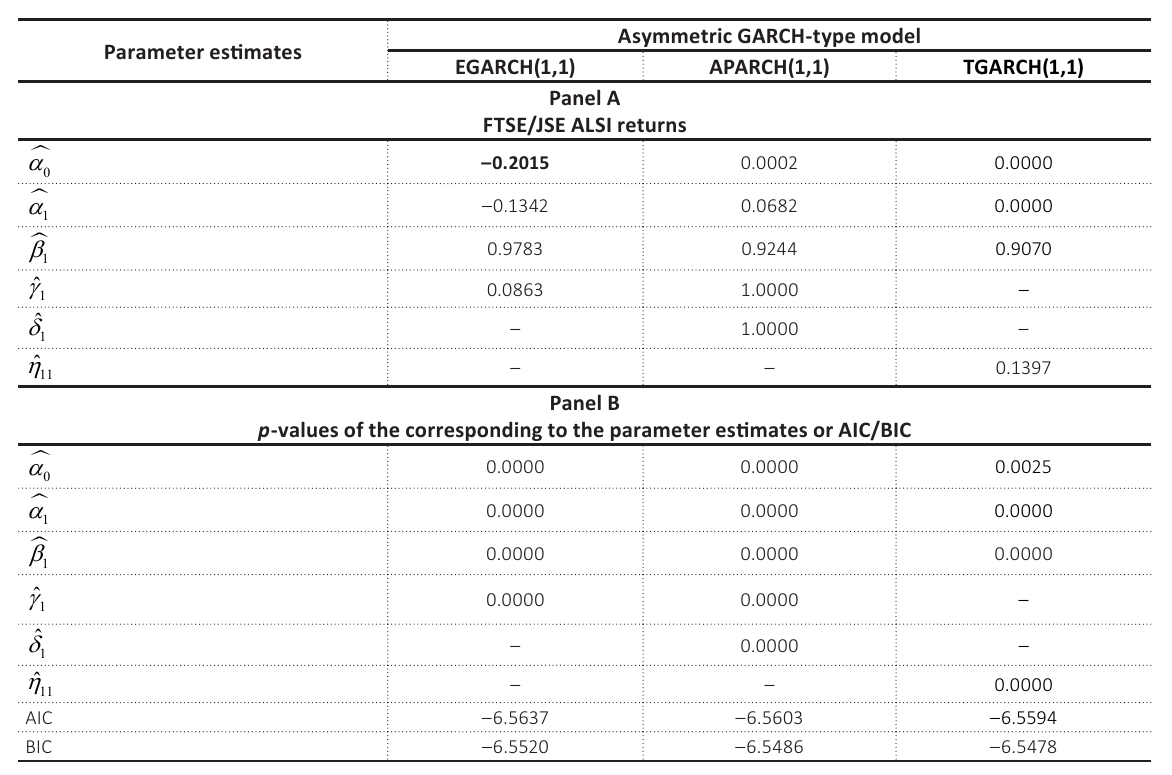
Table 4. ML parameter estimates for asymmetric GARCH-type models with normal innovations on ALSI